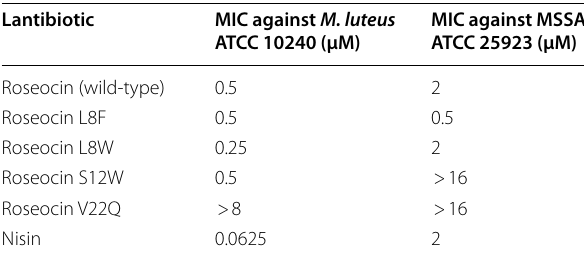
Table 1 Minimal inhibitory concentration (MIC) of wild-type roseocin and its variants Lantibiotic MIC against M. luteus ATCC 10240